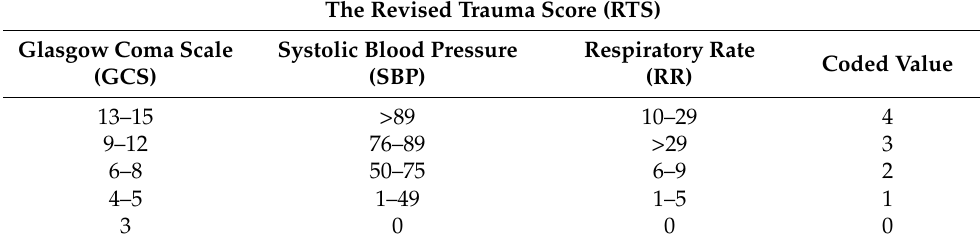
Table 1. Revised Trauma Score. The Revised Trauma Score